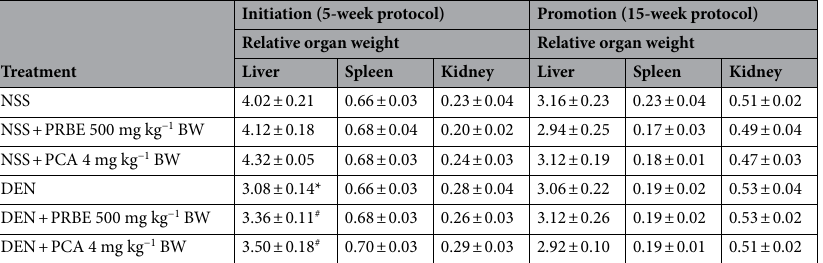
Table 2. Relative organ weight of rats with DEN-induced hepatocarcinogenesis treated with purple rice bran extract and protocatechuic acid. Values are expressed as mean ± SD. DEN: diethylnitrosamine, NSS: normal saline solution, PCA: protocatechuic acid, PRBE: purple rice bran extract. *Significantly different from the negative control group, p < 0.05. # Significantly different from the positive control group, p <